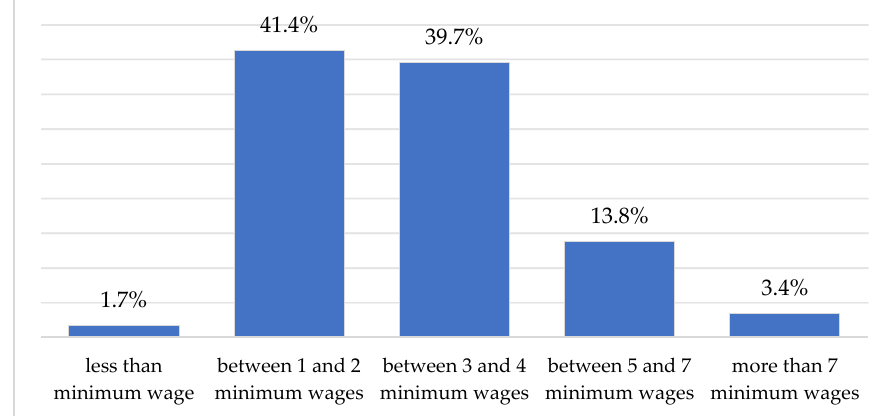
Figure 5. Family income in the Residential complex [22].